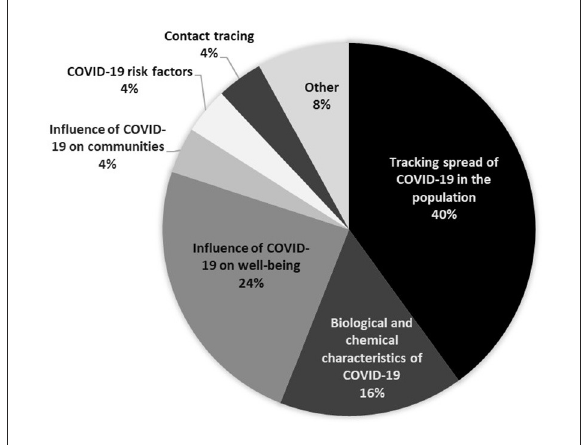
FIGURE1 Primary aims of CS projects investigating COVID-19.